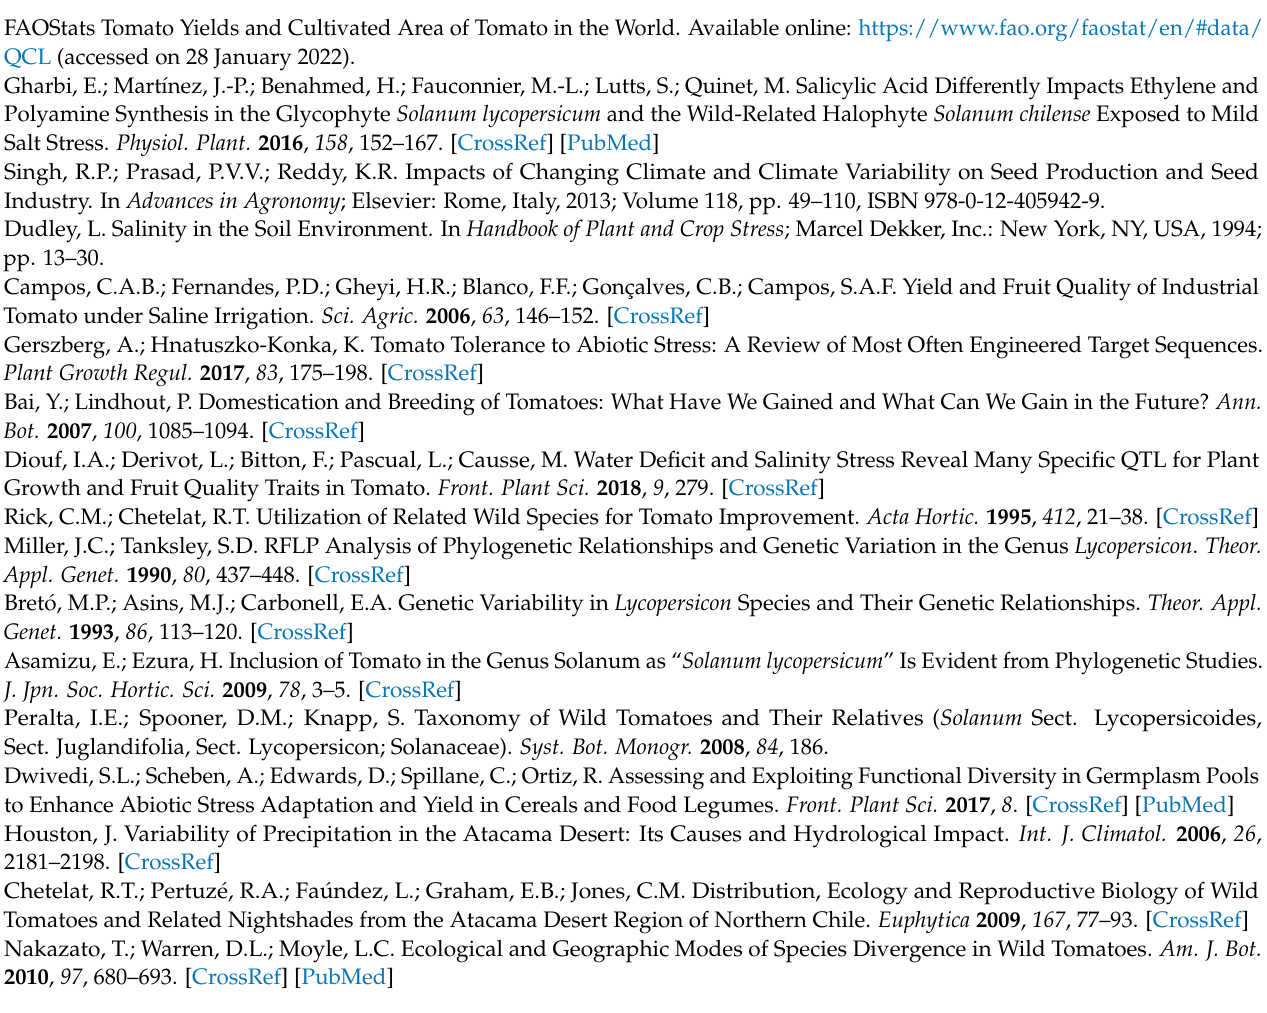
legend of Figure S1, Table S1: List of genes and their primers used for qRT-PCR and their efficiency, Table S2: Statistical results for the analyzed